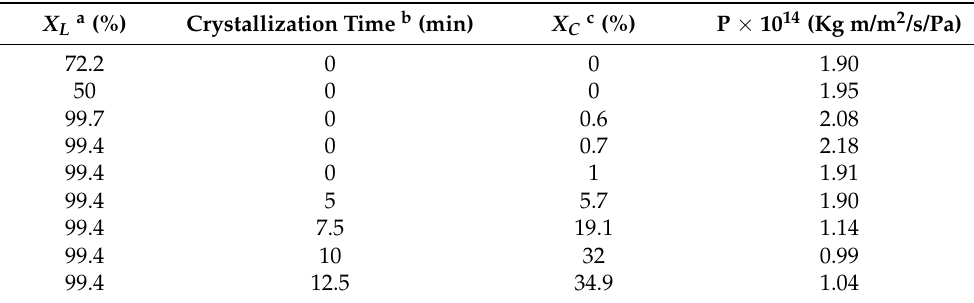
Table 2. Water vapor permeation coefficient (P water ) of PLA films measured at 25 ◦ C as a function of degree of crystallinity ( X c ) and crystallization time. Data taken from [78]. X L a (%) Crystallization Time b (min) X C c